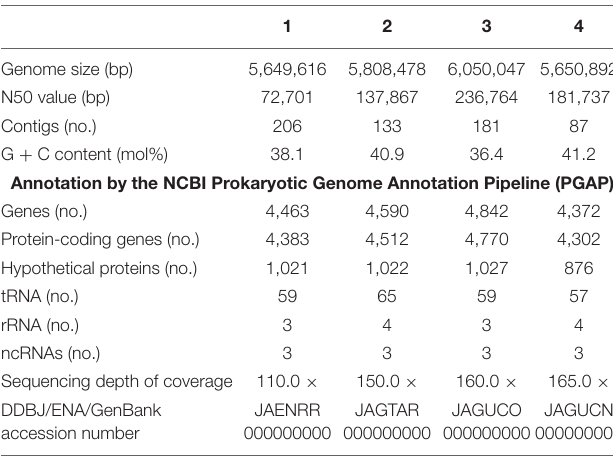
TABLE 3 | Genome statistics of strain N1Y132 T and the related Carboxylicivirga